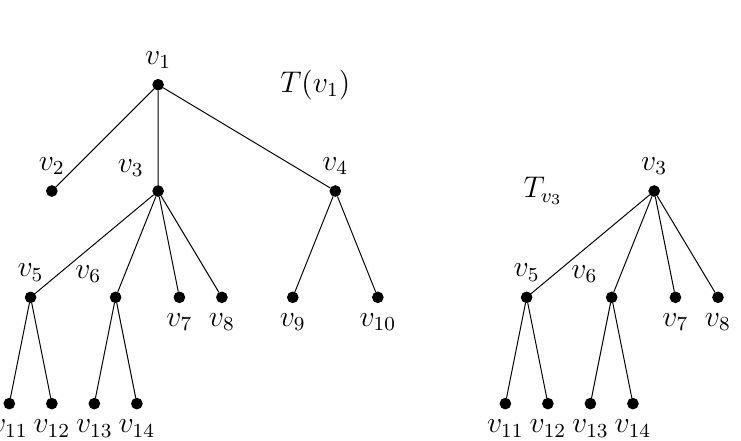
is a rooted subtree of the rooted tree T ( v v 3 , v , v , v , v , v } 7 8 11 12 13 14